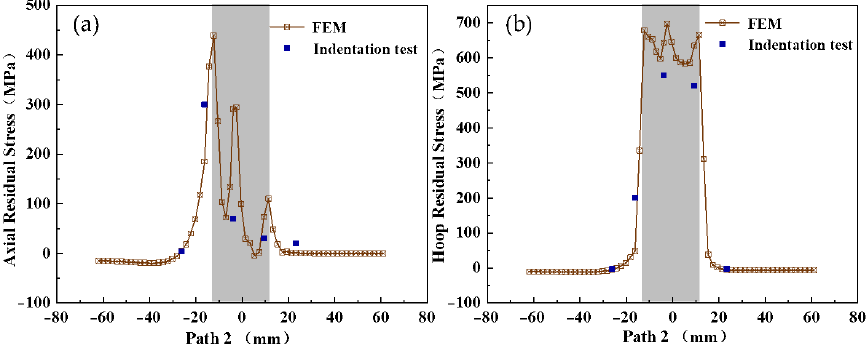
Figure 11. Residual stress distribution of path 2. ( a ) Axial residual stress, ( b ) hoop residual stress.